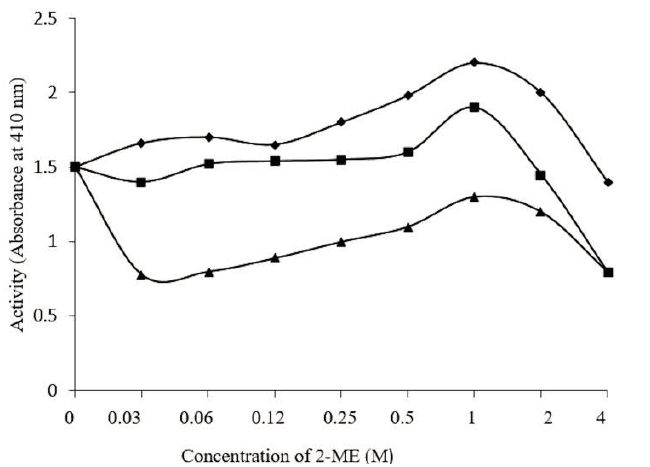
Figure 10. Profile of activity of β -glucosidase in the presence of different concentrations of a reducing agent (2-ME), incubated ♦─♦ 10 min, ■─■ 90 min, and ▲─▲ 24 h. Phosphate buffer, pH 5.0, and 1 mg/mL of purified enzyme, at 35 °C.